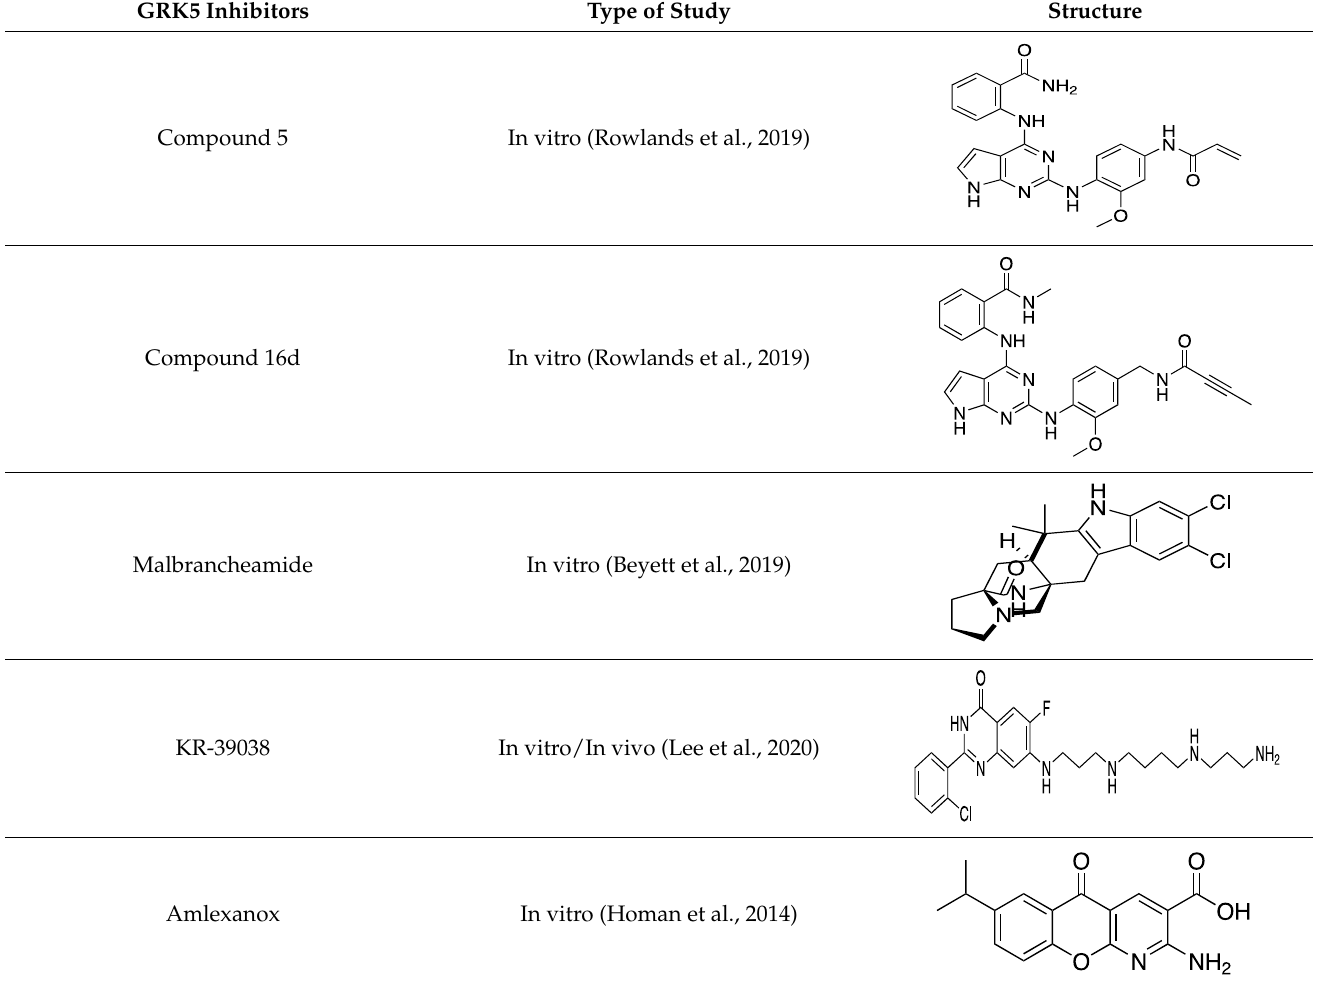
In vitro (Rowlands et al., 2019)